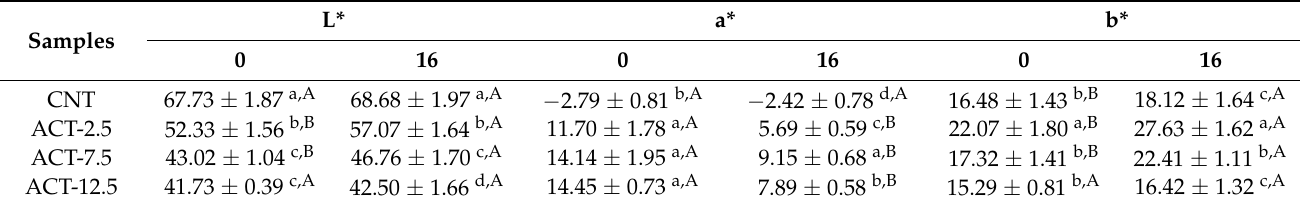
Data indicate means ± SD. Values marked with different superscript letters (a–d) in the column and superscript uppercase letters (A, B) in the row are significantly different ( p < 0.05). CNT: fish burger without prickly pear powder; ACT-2.5: fish burger enriched with 2.5 g of prickly pear powder; ACT-7.5: fish burger enriched with 7.5 g of prickly pear powder; ACT-12.5: fish burgers enriched with 12.5 g of prickly pear powder. L* = lightness (0 = darkness, 100 = lightness); a* = redness (+60 = red, − 60 = green); b* = yellowness (+60 = yellow, − 60 =